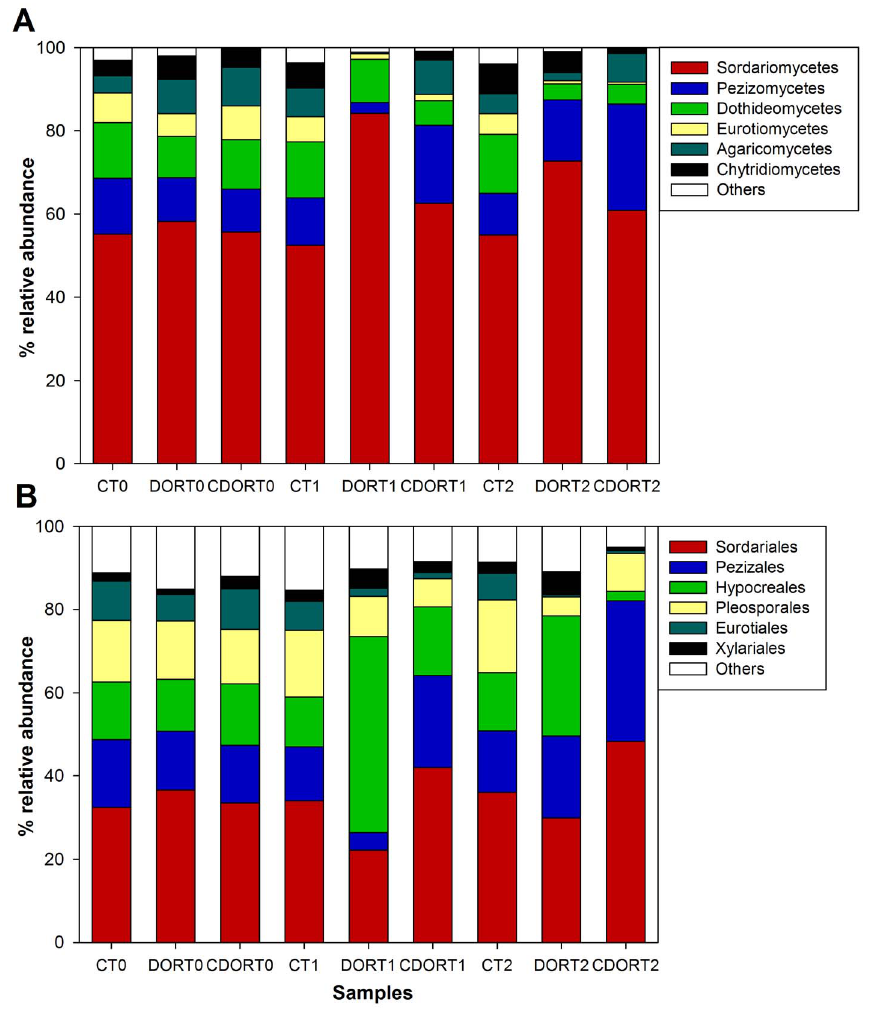
Figure 7. Relative abundance of the different fungal classes (A) and orders (B) found in unamended soil (C) and soil amended with untransformed DOR (DOR) or C.floccosa –transformed DOR (CDOR) at 0 (T0), 30 (T1) and 60 (T2) days. Figure S1 Bacterial rarefaction curves. Rarefaction curves for bacteria obtained from unamended soil (C) and soil amended with